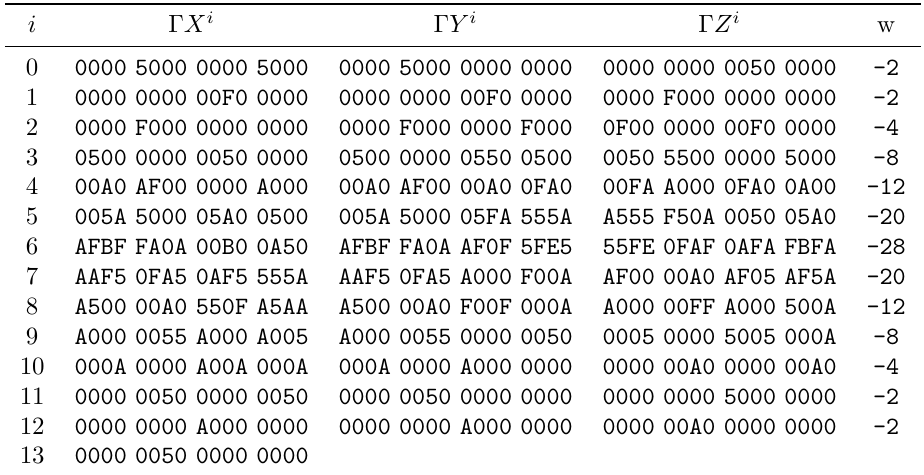
Table 11: A valid linear trail with weight 124, corresponding to the linear hull